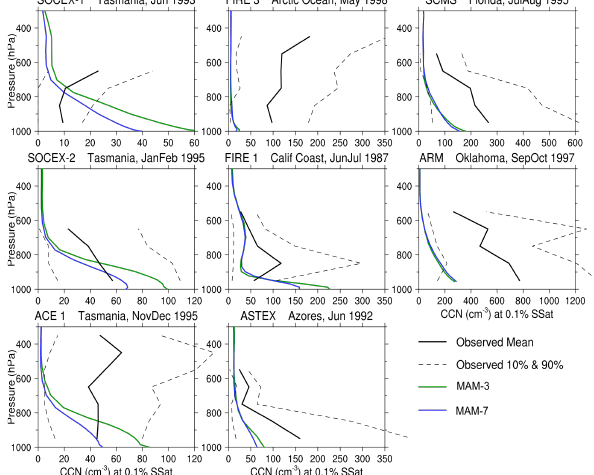
Figure 23. Observed and simulated vertical profiles of CCN concentrations at 0.1% supersaturation for eight field experiments. Field experiment acronym, location, and date are shown above each plot, and more details are given in Table 1 of Ghan et al. (2001). Observed values are means (solid black lines) and 10 th and 90 th percentiles (dashed black lines) for each experiment. Simulated values (colored lines) for MAM3 and MAM7 are averages over the months shown and experiment location.